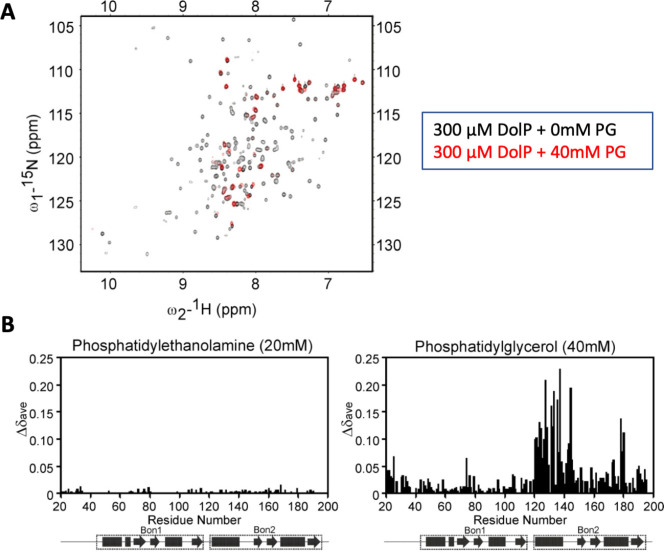
DolP phosphatidylglycerol binding HSQC spectra.(A) 1H,15N HSQC spectra of 15N-DolP (300 μM) in the presence (red) and absence (black) of 40 mM 1,2-dihexanoyl-sn-glycero-3-phospho-(1'-rac-glycerol) (DHPG) highlighting the large chemical shift perturbations observed on DHPG binding. (B) Histograms showing the normalised CSP values observed in 15N-labelled DolP (300 μM) amide signals in the presence of 5 mM cardiolipin, 20 mM 1,2,-dihexanoyl-sn-glycero-3-phosphethanolamine and 20 and 40 mM 1,2-dihexanoyl-sn-glycero-3-phospho-(1'-rac-glycerol).